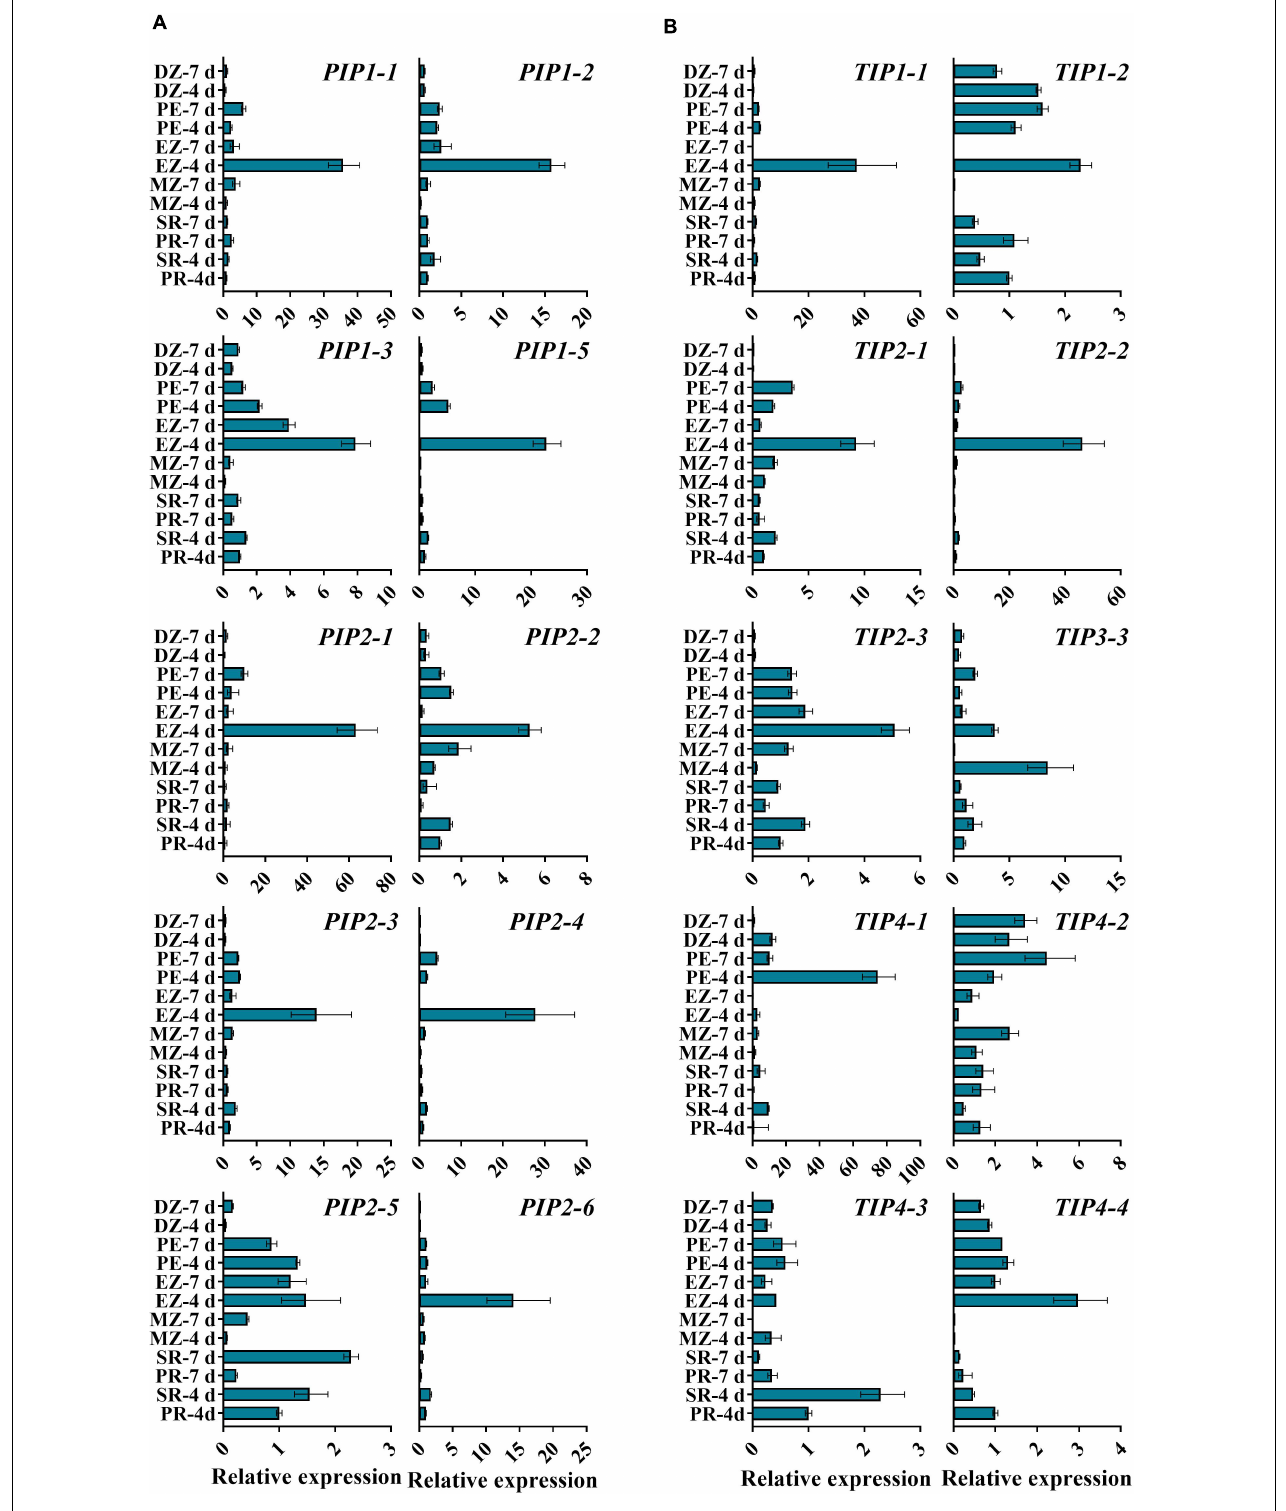
FIGURE 4 | qRT-PCR analysis of the expression levels of ZmAOPs in different zones of the seedling root. The relative transcript levels of ZmPIPs (A) and Zm TIPs (B) in B73. Samples from roots at 4 or 7 days after seed imbibition were used in the assay. ACTIN 1 was used as an internal control. Data are means ± SD ( n = 3). PR, primary root; SR, secondary root; MZ-root cap and meristem zone of the primary root; EZ-elongation zone of the primary root; PZ-post elongation zones of the primary root; DZ-differentiation zone of the primary root.